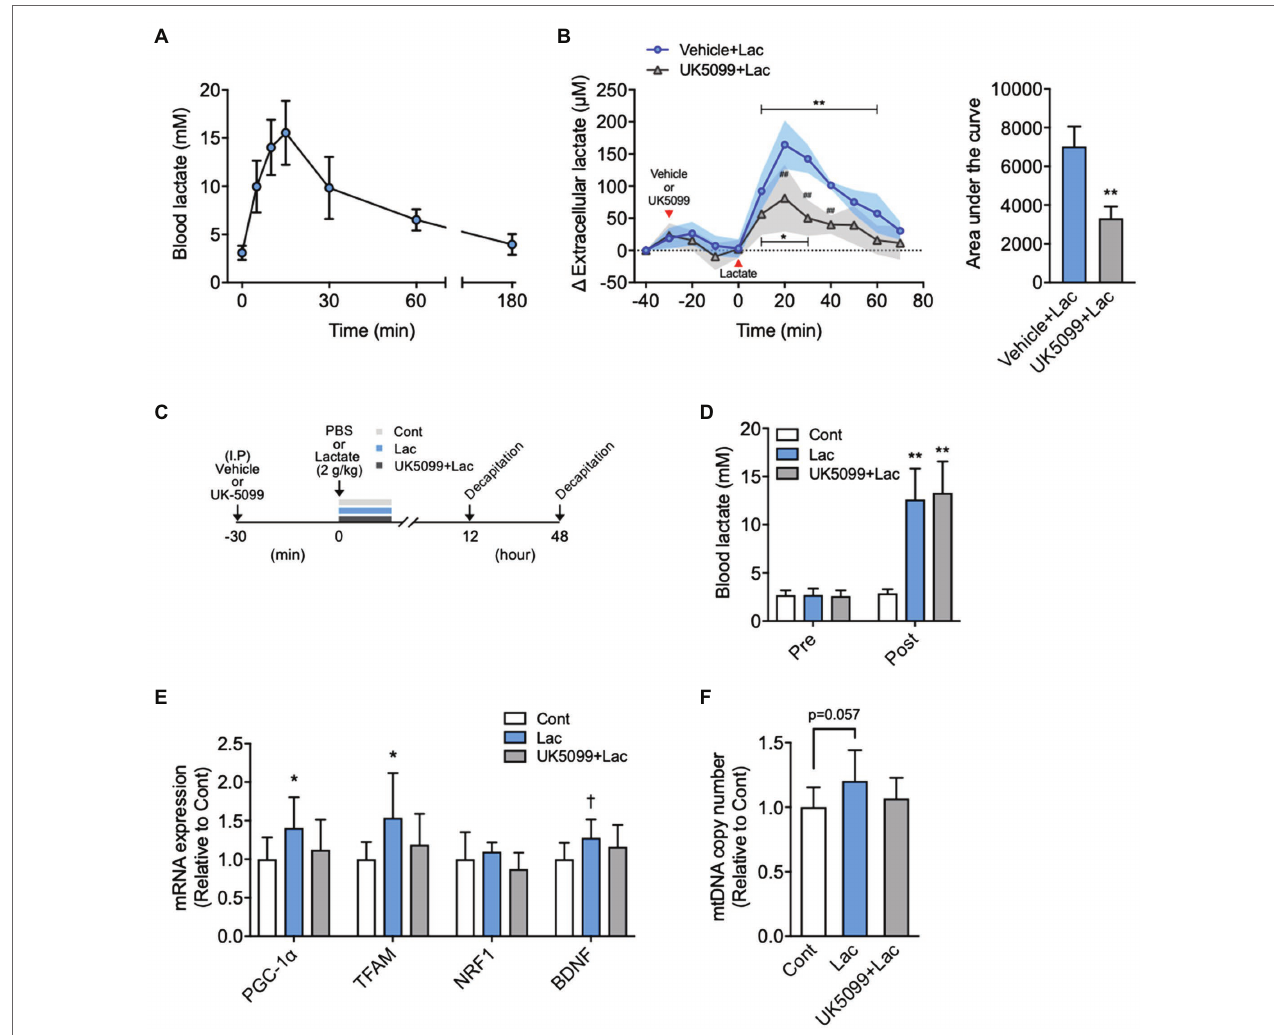
FIGURE 2 | Effects of lactate administration on hippocampal extracellular lactate concentration and mitochondrial biogenesis in the hippocampus. (A) Time course changes in blood lactate concentration after I.P. lactate injection (2 g/kg; n = 6). (B) The hippocampal extracellular lactate concentration changes after I.P. lactate injection with saline or monocarboxylate transporters (MCT) inhibitor (UK5099) administration and area under the curve (Vehicle + Lac, n = 4; UK5099 + Lac, n = 5). (C) Experimental design: Mice were injected saline or UK5099 by I.P. injection 30 min before lactate administration. Blood lactate concentration was measured 15 min after I.P. lactate or saline injection. (D) Blood lactate concentrations before I.P. lactate injection (Pre) and after lactate injection with and without UK5099 (Post). (E) PGC-1 α , mitochondrial transcription factor A (TFAM), nuclear respiratory factor1 (NRF1), and brain-derived neurotrophic factor (BDNF) mRNA expression in the hippocampus 12 h after I.P. lactate injection with and without UK5099 (Cont, n = 9; Lac, n = 9; UK5099 + Lac, n = 8). (F) mtDNA copy number in